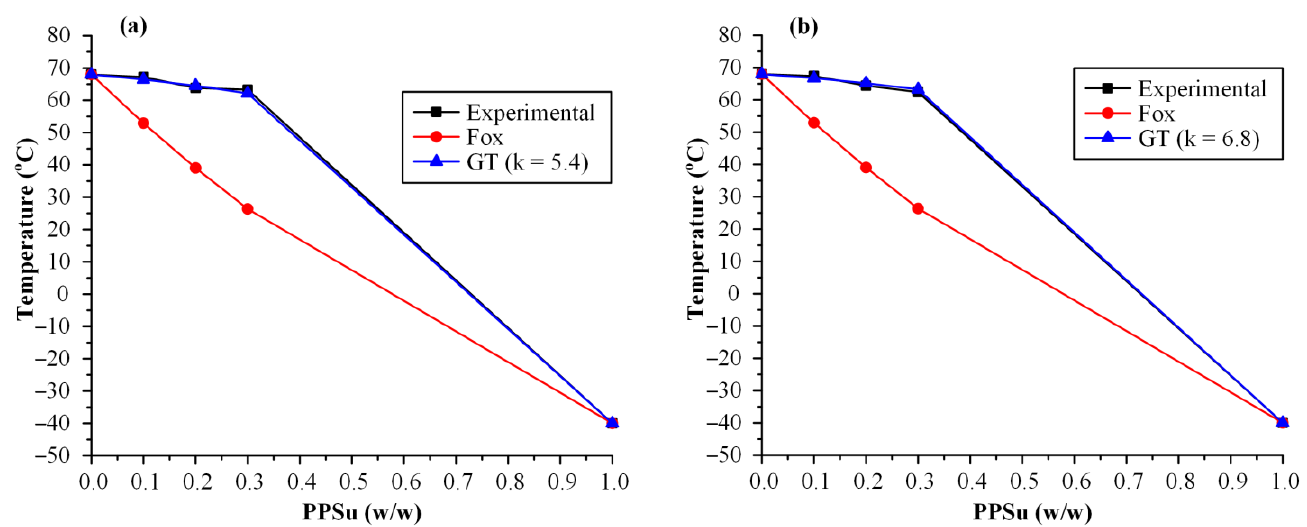
Figure 5. Prediction of T g − composition dependence in PVA − PPSu blends prepared after 3 min ( a ) or 10 min ( b ) of melt- mixing, using either the Fox or the Gordon – Taylor (GT) fitting equations.